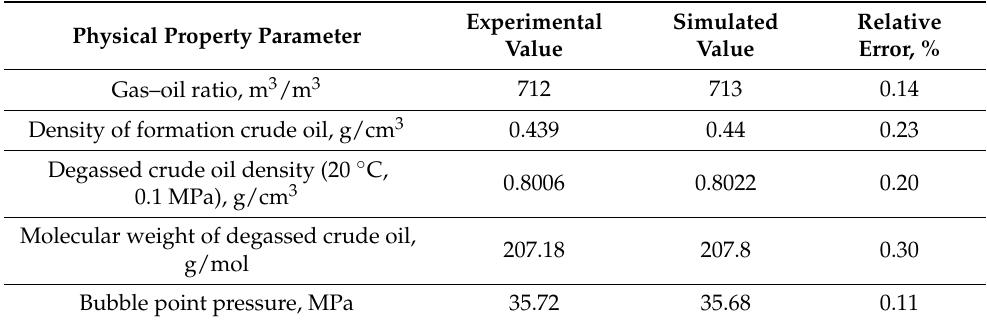
Table 6. Comparison of two-phase flash experimental data and simulation